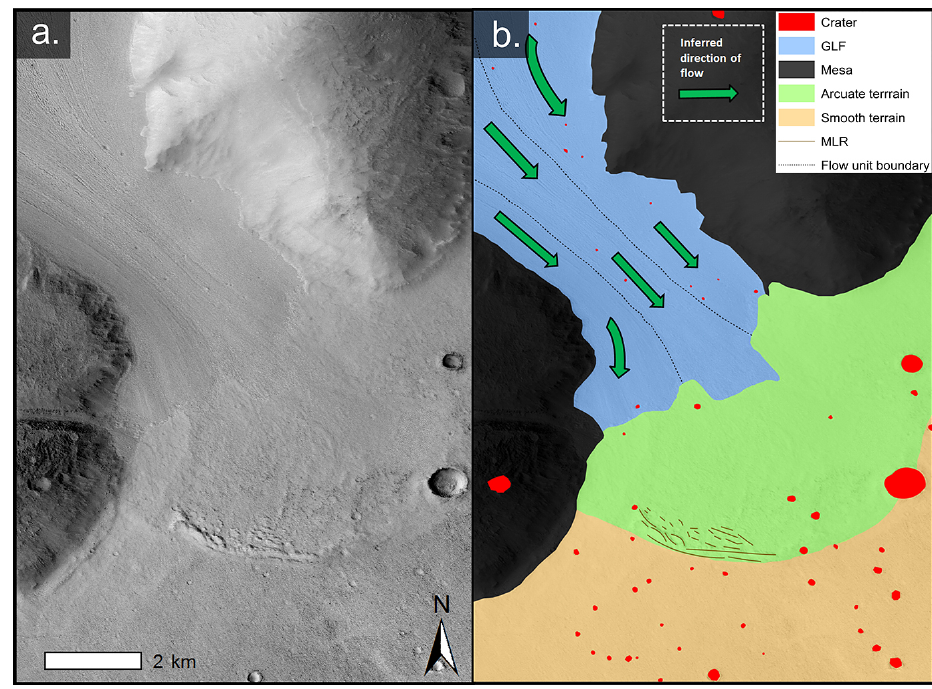
Figure 4. Geomorphological interpretation of GLF #146 illustrated in Fig.